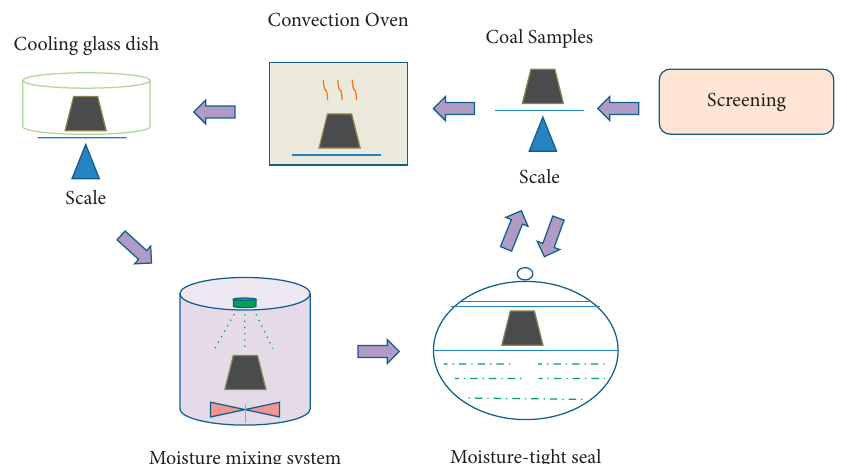
Figure 4: Preparation of coal samples and its moisture